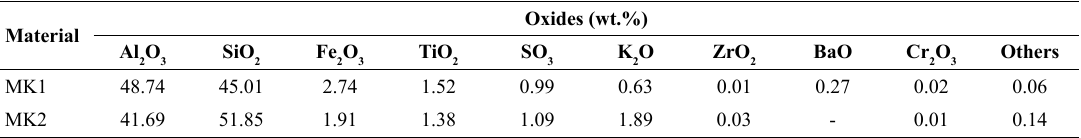
Table 1. Chemical composition, normalized to 100% by mass.